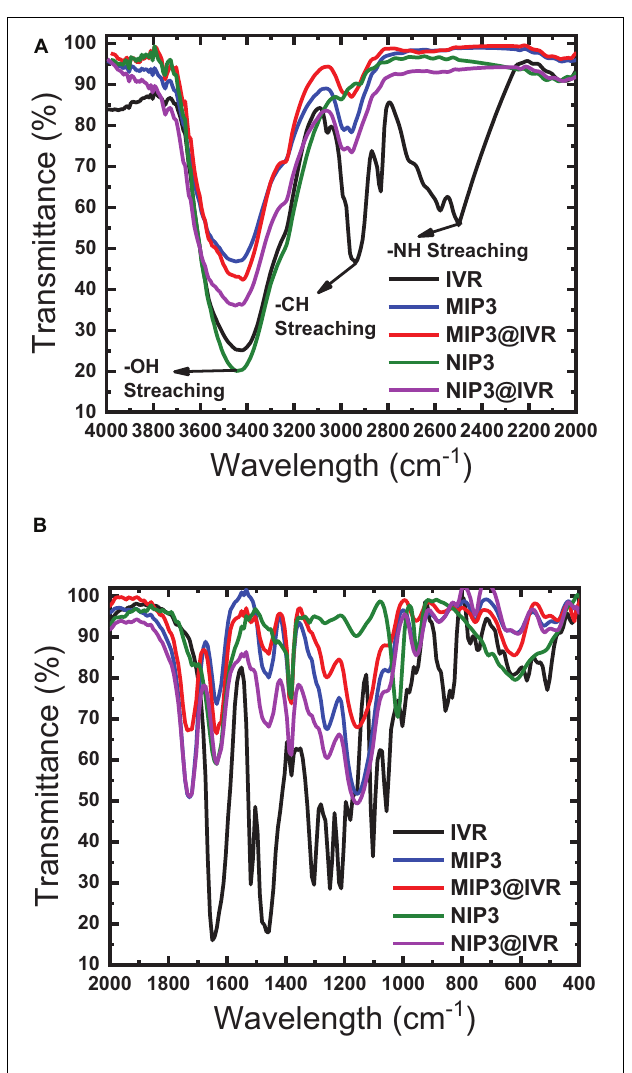
FIGURE 5 | FTIR spectra of MIP3, NIP3, and IVR before (leached) and after interaction (unleached) in ranges (A) 2,000–4,000 cm − 1 and (B) 400–2,000 cm − 1